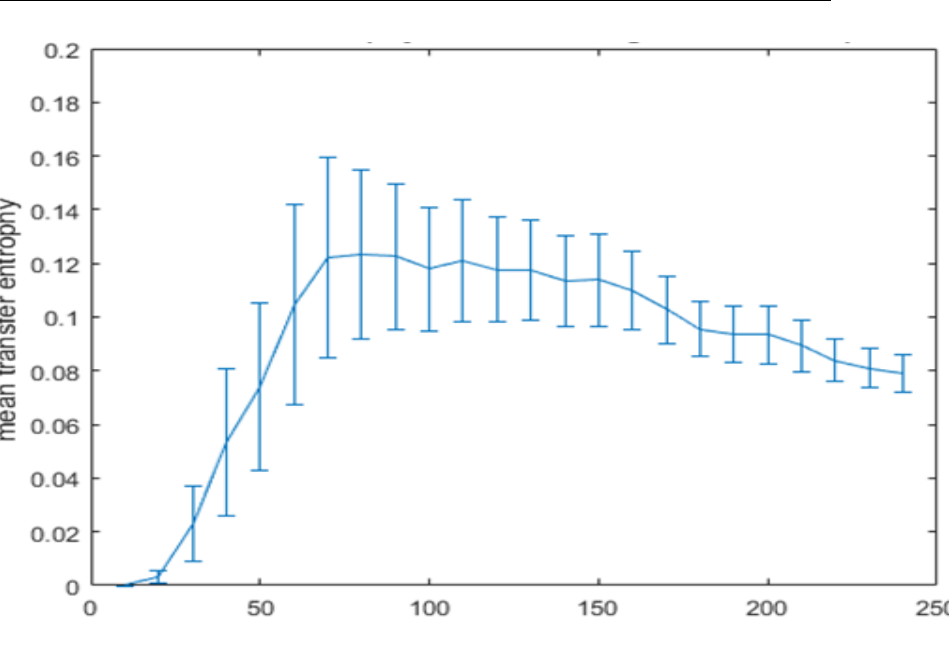
Figure 5. Average transfer of information transferred to companies of Tehran Stock